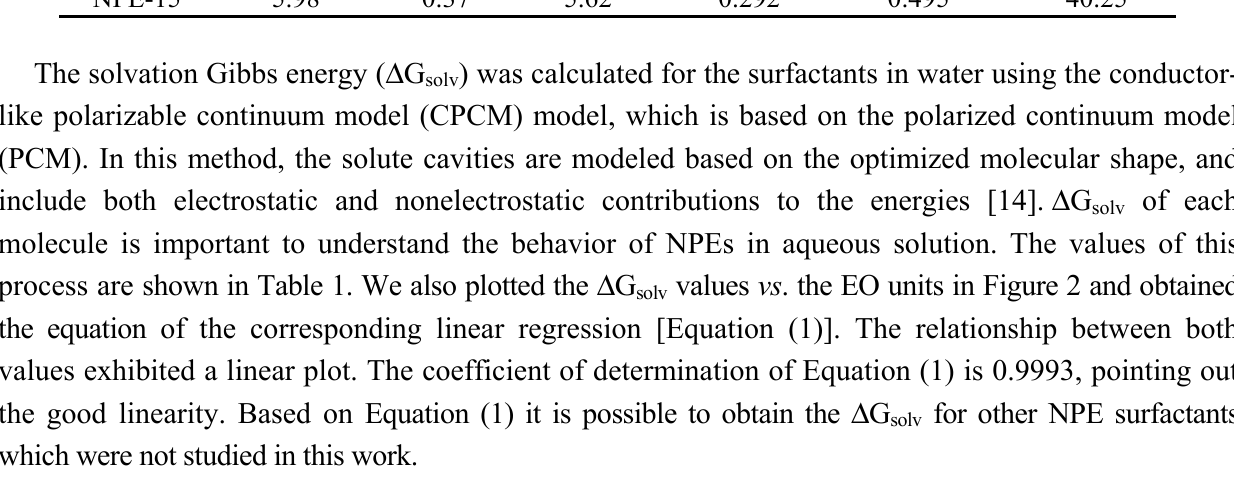
Figure 2. Relationship between Δ G